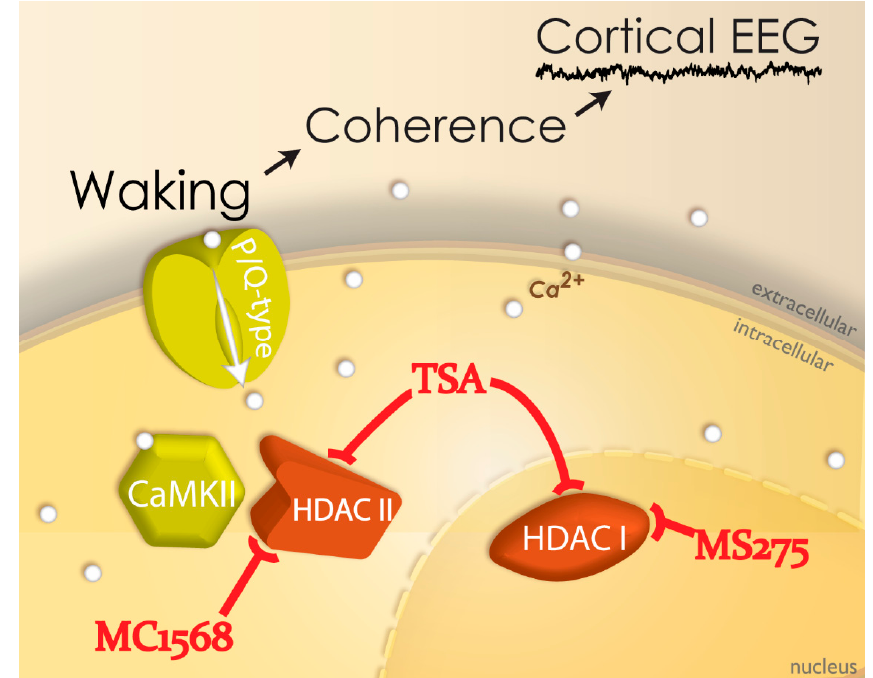
Figure 2. Neuroepigenetic mechanisms behind gamma during waking. Trichostatin A (TSA) was found to block HDACI that remains in the nucleus and HDACII that can travel to the cytoplasm. MS275 blocked HDACI but had no effect on gamma oscillations, while MC1568 blocked HDACIIa and also gamma oscillations. This suggests that TSA blocked HDACIIa in the cytoplasm and generated a deleterious effects on gamma oscillations. Conversely, the manifestation of gamma oscillations through P/Q-type calcium channels during waking, which leads to coherent activity across distant sites in the cortical EEG, modulates gene transcription through HDACIIa.